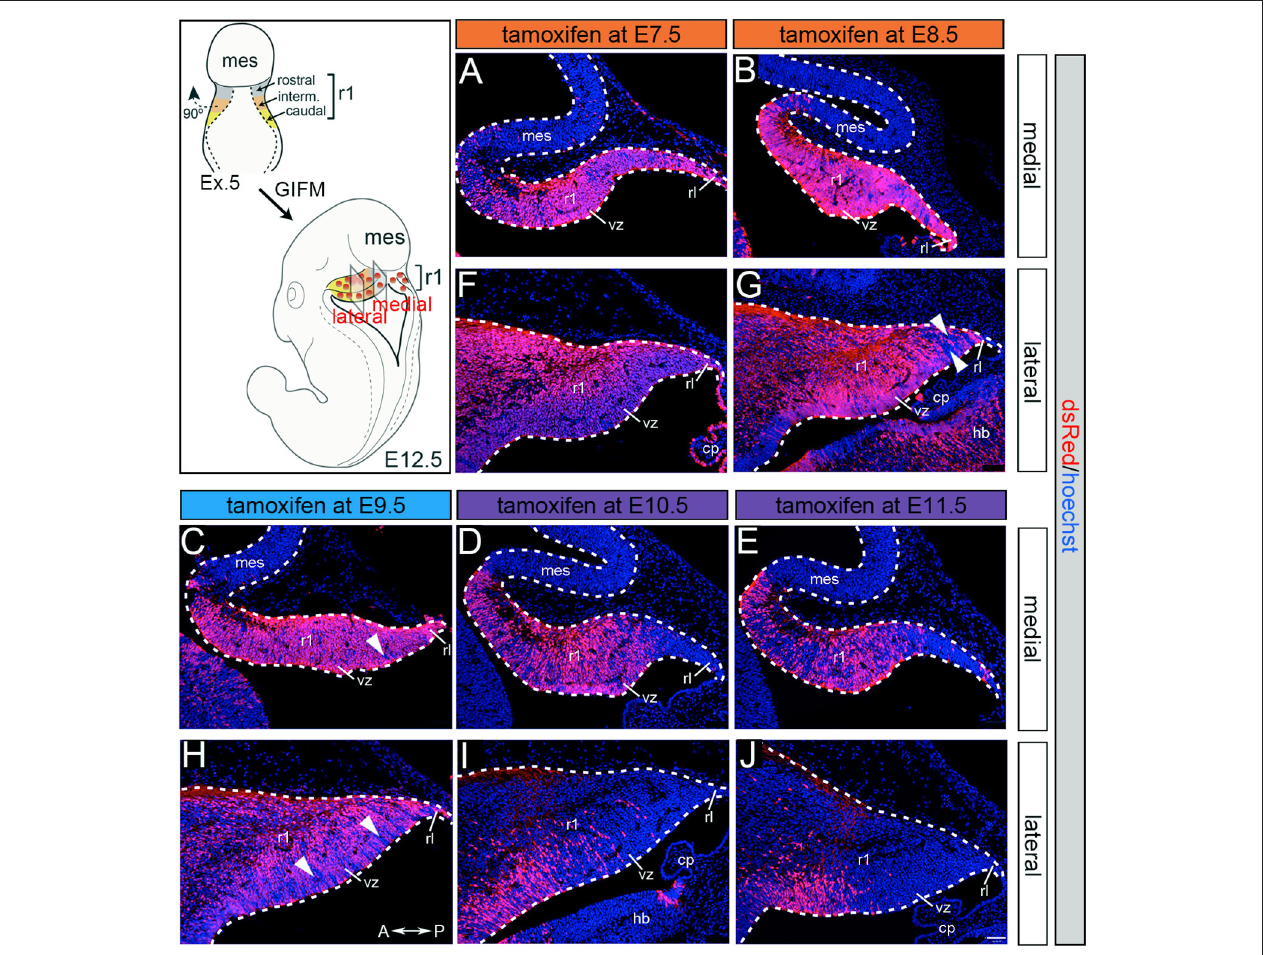
FIGURE 1 | Gbx2 expressing precursors differentially populate the Cb primordia. ICC with an antibody recognizing tdTomato (DsRed, red is produced from recombination of the Rosa26 tdTomato allele) on E12.5 fate mapped sagittal sections. (A,F) The Gbx2 lineage marked at E7.5 gave rise to a majority of cells in the ventricular zone (vz), rhombic lip (rl), and core of rhombomere 1 (r1) in medial and lateral r1. Notably, a small number of Gbx2 -derived cells was observed in the mesencephalon (mes). (B,G) The Gbx2 lineage marked at E8.5 also contributed to cells throughout the vz and rl in the Cb primordia. (C,H) The Gbx2 lineage marked at E9.5 produced the largest contribution of cells in medial r1. However, cohorts of cells with clonal-like labeling was apparent in the vz of lateral r1. (D,I) The Gbx2 lineage marked at E10.5 preferentially populated the anterior aspect of medial r1, but was nearly absent in the rl. In contrast, lateral r1 was devoid of labeling in the core differentiated zone and the rl. There was also diminished labeling in the posterior vz. (E,J) The Gbx2 lineage marked at E11.5 was diminished in its contribution throughout medial r1 and marked cells appeared clonal-like in nature. Only a small population of marked cells was observed in the anterior-lateral vz. White arrowheads indicate unmarked cohorts of cells. Scale bar: 61 µ m. See Supplemental Figure 1 for fate mapping schematic summarizing alleles and